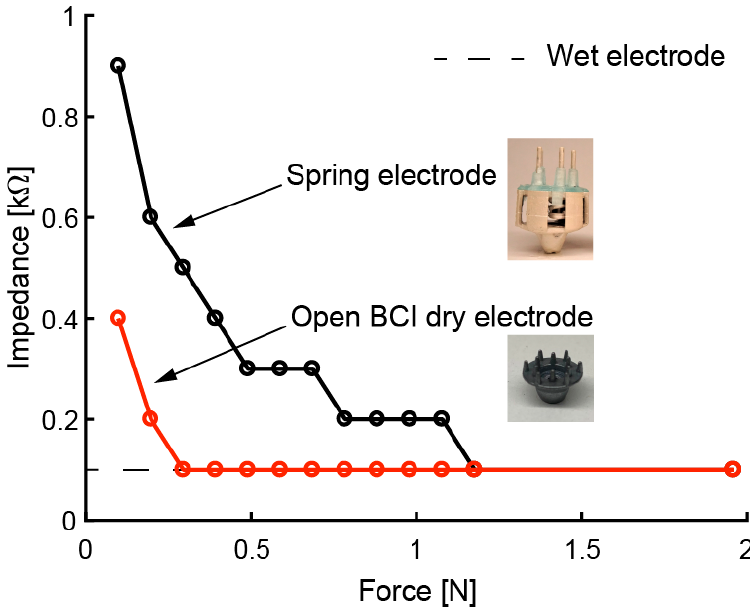
Figure 9. Contact impedance of electrodes when pressed against phantom head with different levels of force.